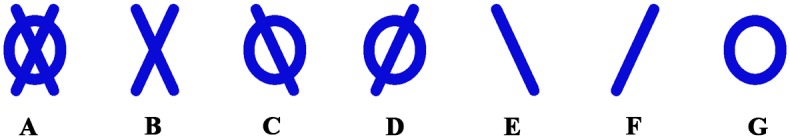
Target stimuli.The symbols that were used as target stimuli.